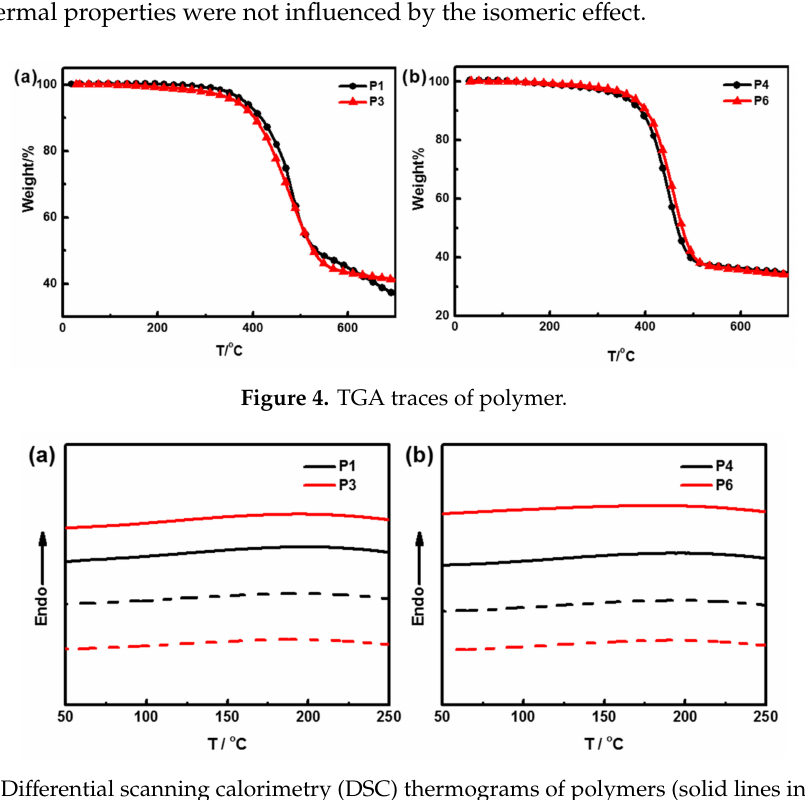
Figure 5. Di ff erential scanning calorimetry (DSC) thermograms of polymers (solid lines indicate the heating DSC scan, and dash lines indicate cooling DSC scan).